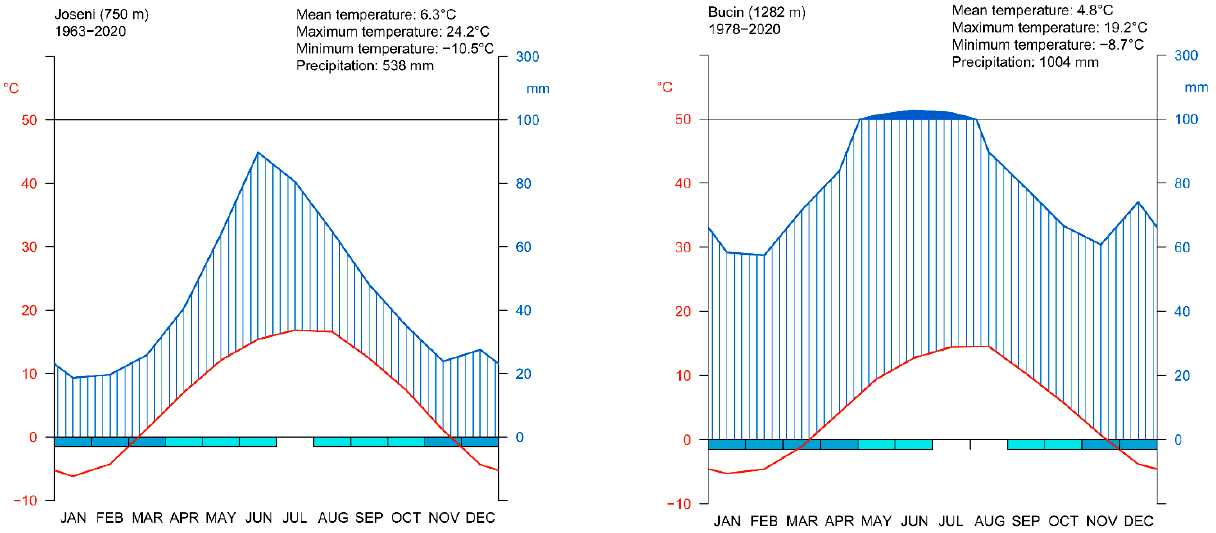
Figure 7. Climate diagrams according with Walter and Leith [77] for the local weather stations in the study area (valley station on the right and up-hill station on the left). The red line represents the variations of the mean monthly temperatures, the blue line represents the variations of the monthly precipitation, the blue hatched area represents the humid period, and the blue filled area represents the wet period. The bar in the lower part suggests the indication of months where frost is likely.